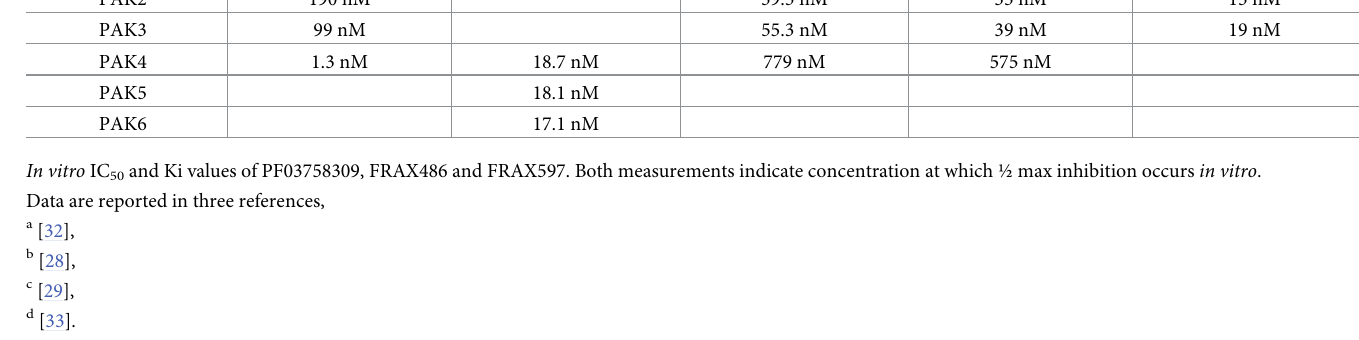
the screening and validation, (Figs 1B and S2, Tables 1 and 2). In the screening, FRAX486 did not show an altered ratio, suggesting lack of synergy. Although not included in the screening, synergy with Ribociclib was tested for another partial PAKi, FRAX597 (Table 2 and S3 Fig). The results of the validation show strong synergy between CDK4/6is and PF3758309, but much less so for the combination with FRAX486, consistent with the screening data. No syn-